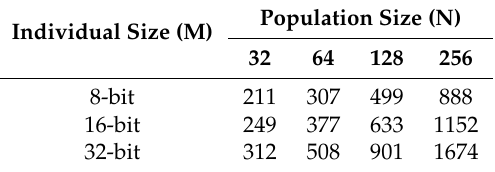
Table 4. Stack memory consumption (in bytes) in the master node, of a total of 2 KB.